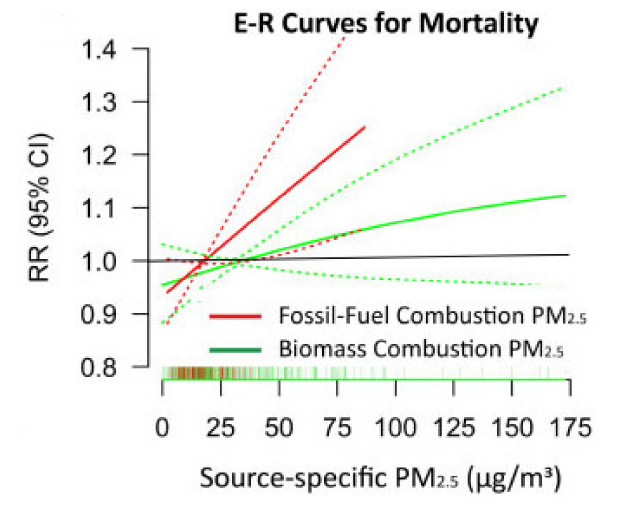
Figure 4. Fossil fuel combustion PM 2.5 vs. biomass PM 2.5 effects on daily mortality in Dhaka, Bangladesh (adapted from [99]) Color dotted lines are 95%ile confidence